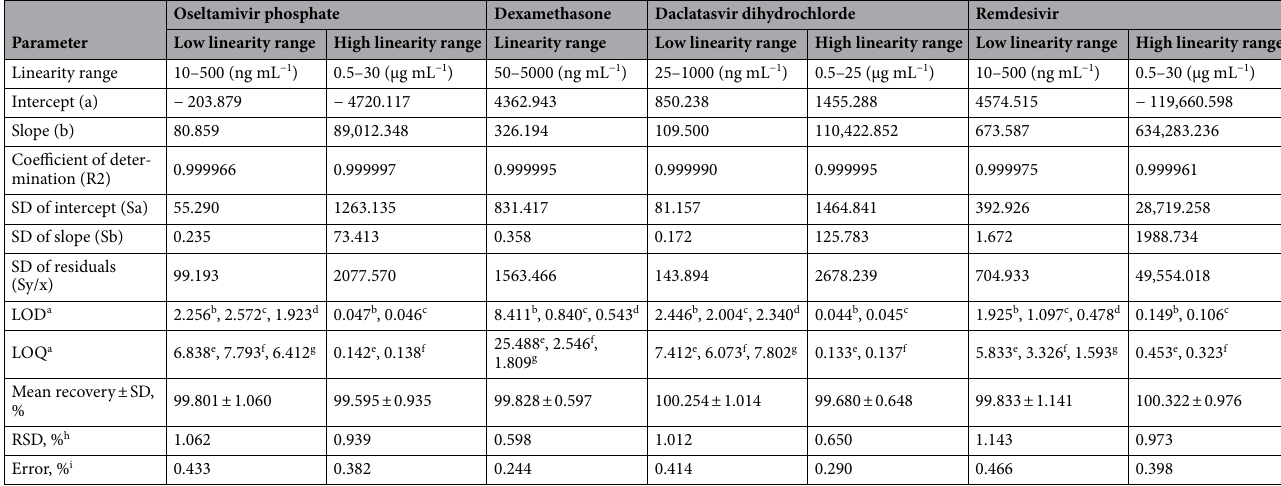
Table 2. Statistical parameters of calibration curves of oseltamivir phosphate/dexamethasone/daclatasvir dihydrochloride/remdesivir using the developed method. a Its units are ng mL −1 for DEX and low linearity OSTP, DAC, and REM ranges, and µg mL −1 for high linearity OSTP, DAC, and REM ranges. b Limit of detection based on the standard deviation of the y-intercept (σ) and the slope of a regression line (S) of the linear calibration curve; LOD = 3.3 σ/S. c Limit of detection based on the standard deviation of the y-intercept (σ) and the slope of a regression line (S) of a specific calibration curve in the range of LOD of the linear calibration curve; LOD = 3.3 σ/S. d Limit of detection based on signal-to-noise ratios (S/N) method. e Limit of quantitation based on the standard deviation of the y-intercept (σ) and the slope of a regression line (S) of the linear calibration curve; LOQ = 10 σ/S. f Limit of quantitation based on the standard deviation of the y-intercept (σ) and the slope of a regression line (S) of a specific calibration curve in the range of LOD of the linear calibration curve; LOQ = 10 σ/S. g Limit of quantitation based on signal-to-noise ratios (S/N) method. h Percentage relative standard deviation for six samples. i Percentage relative error for six samples.